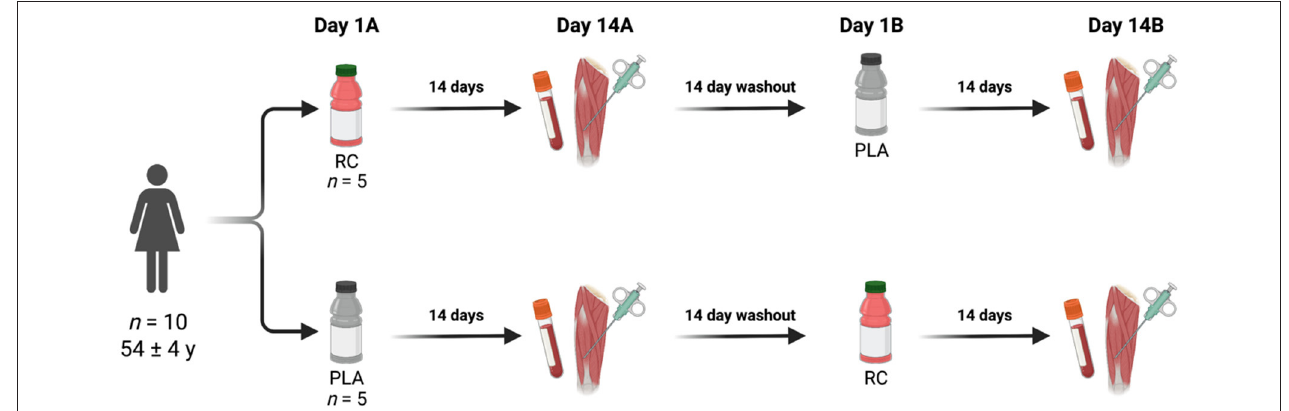
FIGURE 1 | Study design overview. Created with